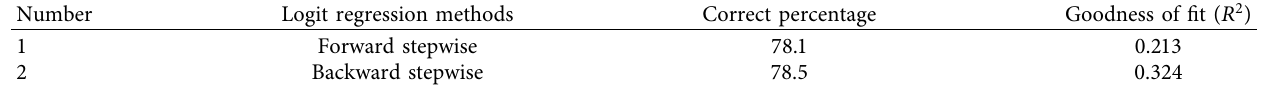
Table 9: Summary of the forward and backward methods of accident severity.